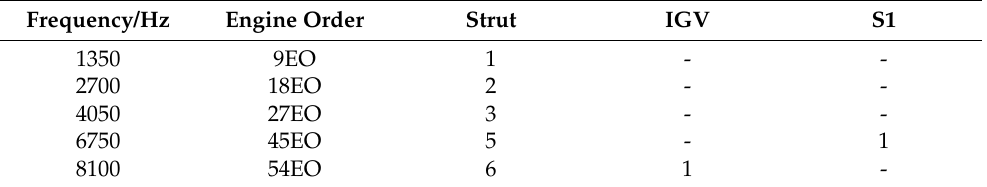
Table 1. The relationship between main frequencies of R1 rotor blade force and number of blades.